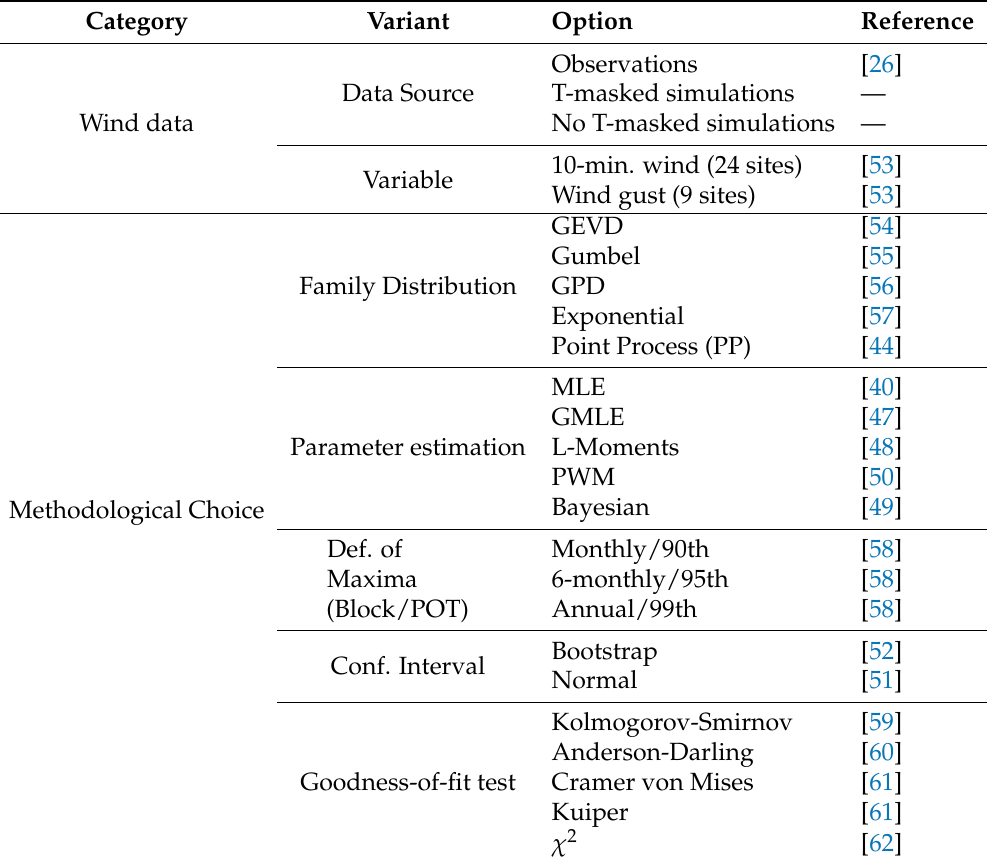
Table 1. Summary of experiments. All methodological variants applied in the first part of this work are indicated. Every one of these configurations is tested over each time series within the observational wind/wind gust data